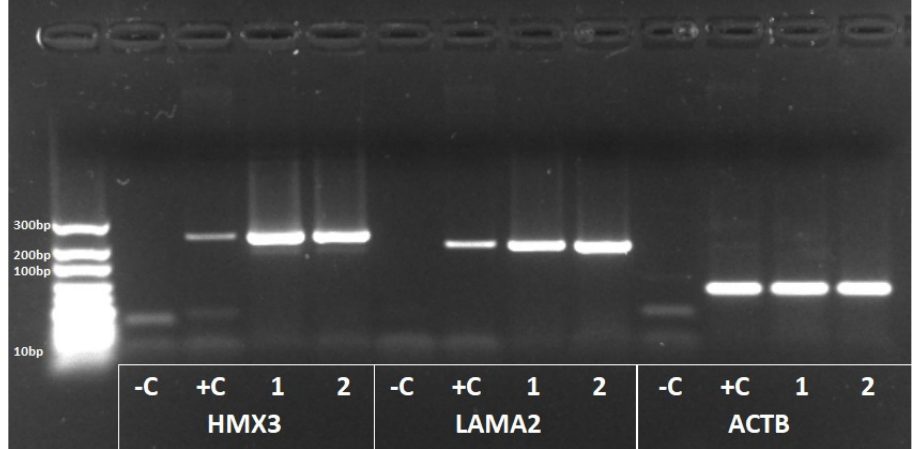
Figure 2. Gel image of RT-PCR products showing strong expression of HMX3 and LAMA2 in human vestibular tissues. (-)C: negative control; +C: positive control; 1 and 2: patients 1 and 2; ACTB : β -actin. In the gEAR database, 12 out of 15 genes in Table 2, including HMX3 and LAMA2 , were detected in bulk RNA-seq data from adult human vestibular sensory epithelia (Forge 2020 dataset). On the other hand, three genes, CTIF, OTOP1 , and OTOP2 , were not found